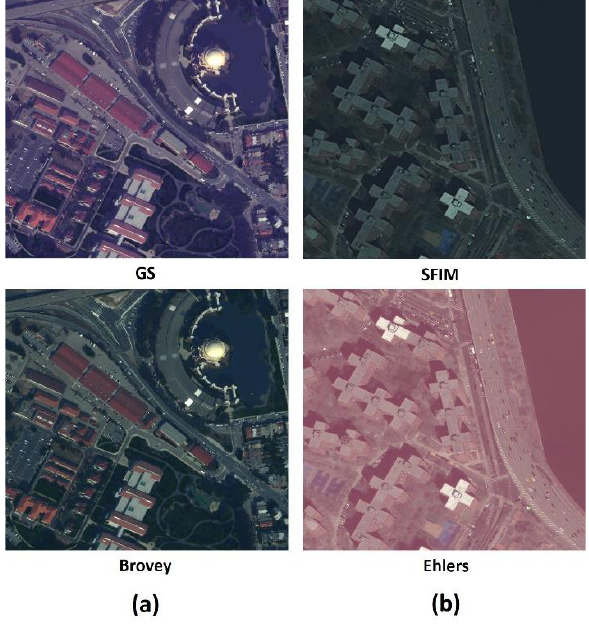
Figure 4. PS results: (a) San Francisco dataset, (b) NY dataset